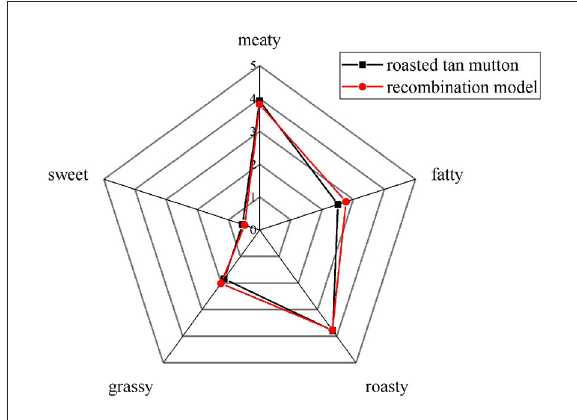
FIGURE3 Aroma profiles in roasted Tan mutton and recombination model.